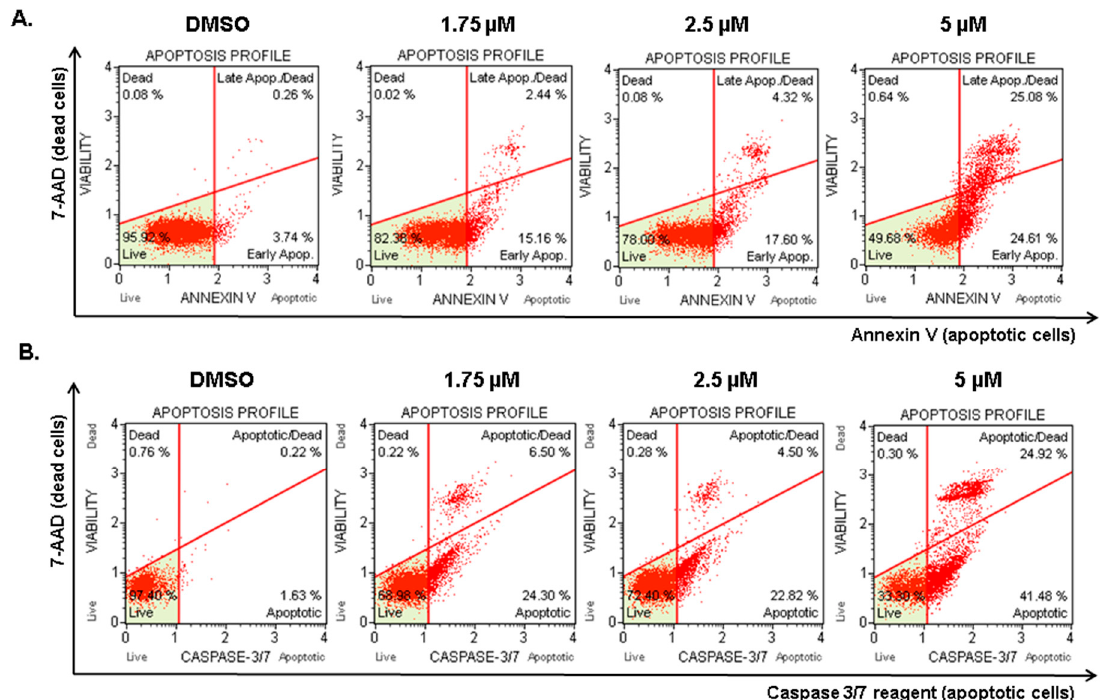
Figure 4. Compound 1 induced apoptotic cell death. After 24 h of incubation with the indicated concentration of compound 1 or DMSO (control), the apoptotic status of 1205Lu cells was analyzed using the Muse TM Annexin V & Dead Cell Kit according to the manufacturer’s instructions. ( A )